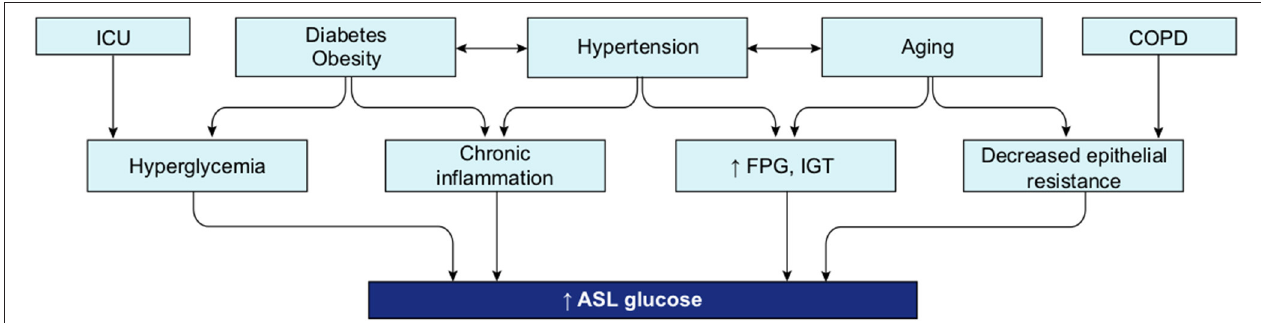
FIGURE 18 | Mechanisms involved in increased ASL glucose concentration in the groups at risk for COVID-19. Both an impaired pulmonary epithelial resistance (due to aging or chronic inflammation among others), or an increase in blood glucose concentration (due to chronic or acute hyperglycemia, increased FPG or IGT) lead to an increase glucose concentration in the ASL, with a greater effect when both coexist (as modeled in Figure 17 ). All group at risk for COVID-19 are presenting one or several of these conditions, explaining that they are all susceptible to present an increased concentration of glucose in their